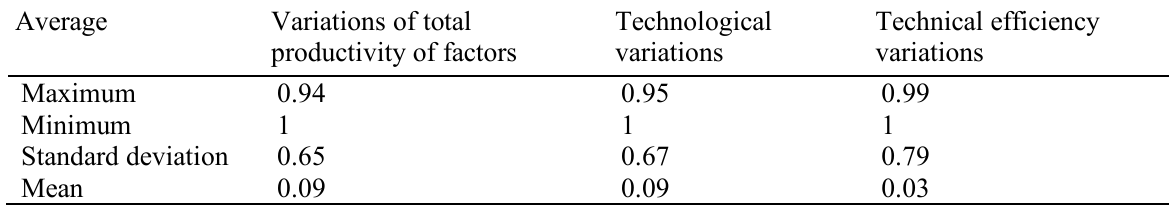
Technological Technical efficiency variations variations